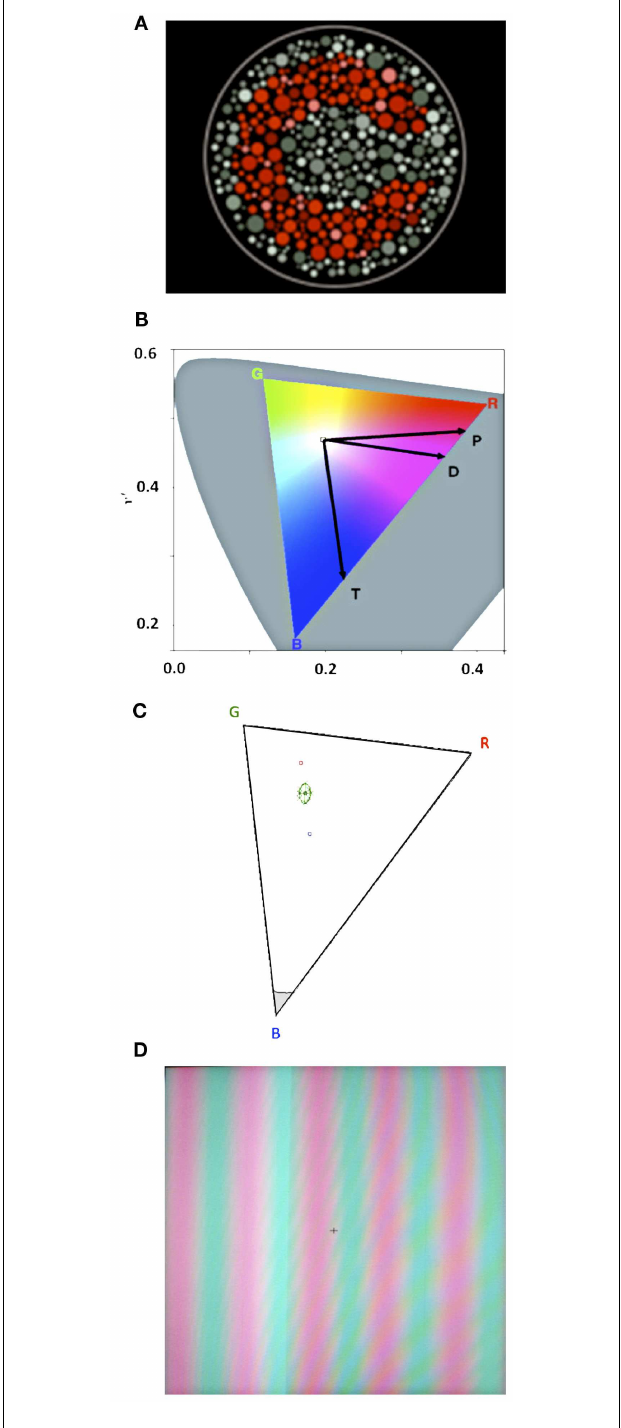
FIGURE 2 | (A) Example of the pseudoisochromatic adaptation of Landolt’s C used in the Cambridge ColorTest 2.0. (B) CIE 1976 color space with color confusion axes. “P” stands for protan, “D” stands for deutan, and “T” stands for tritan.The color triangle represents the monitor’s color gamut within the CIE 1976 color space. (C) Example of a McAdam ellipse with eight vectors in the color triangle. (D) Example of a red-green s ine-wave